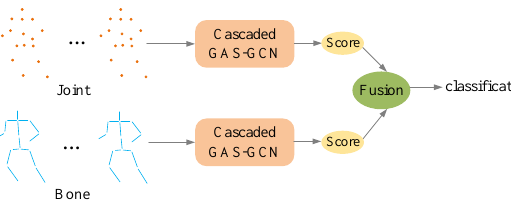
Figure 6. The illustration of two-stream fusion architecture. The two streams use different input data. They have the same architecture. Their prediction scores are added together as the final classification